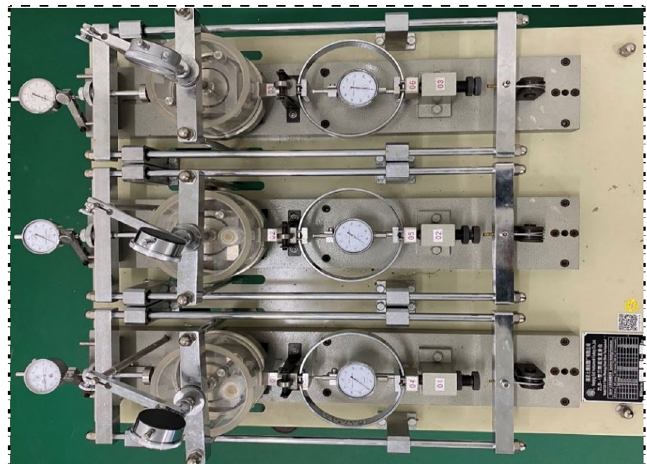
Figure 2. The ZLB-1 direct shear creep testing machine.